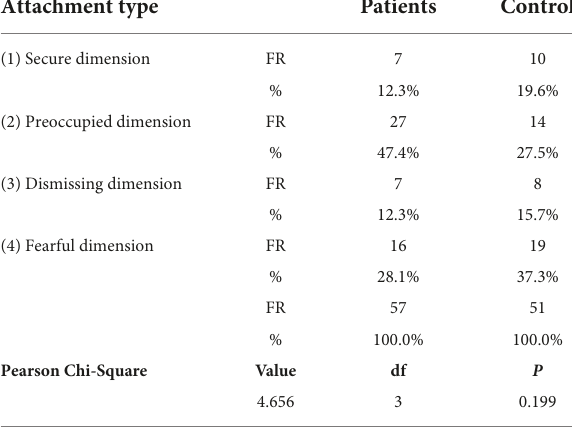
TABLE 4 Comparison of the attachment type between patients and healthy volunteers. Attachment